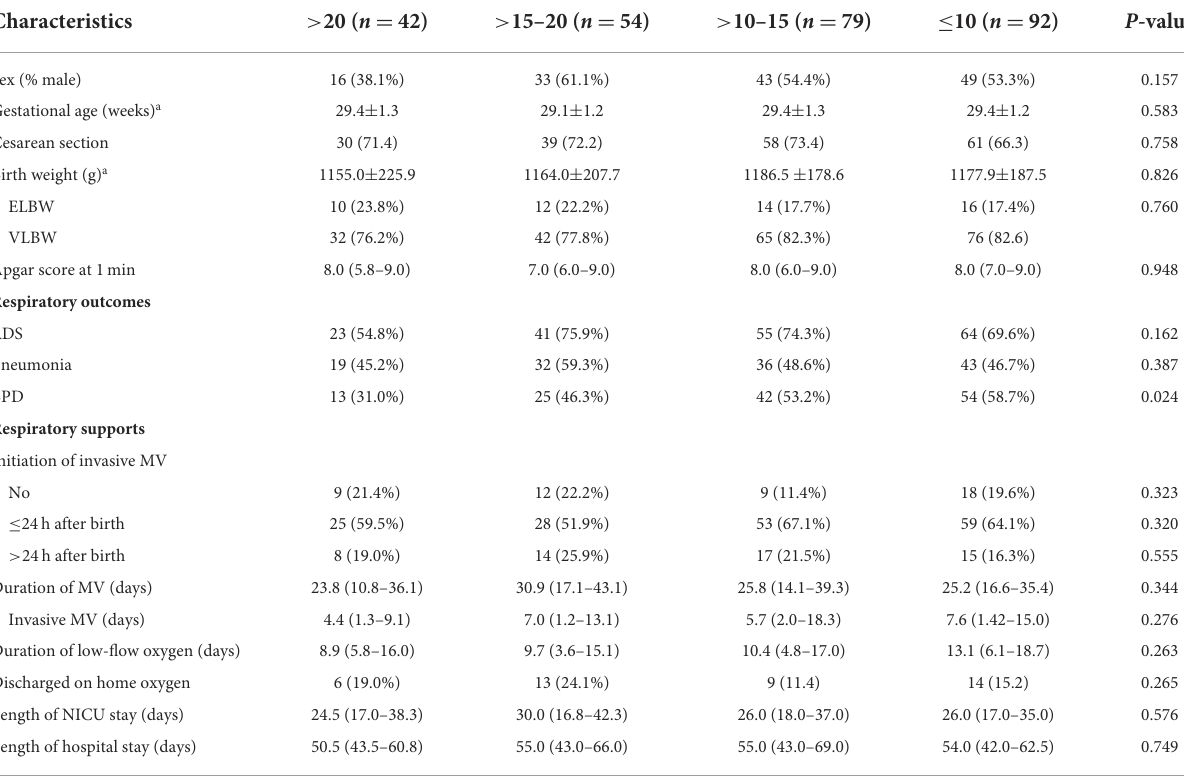
TABLE 1 Demographic and clinical characteristics of preterm infants grouped by cord-blood 25(OH)D levels (ng/ml).